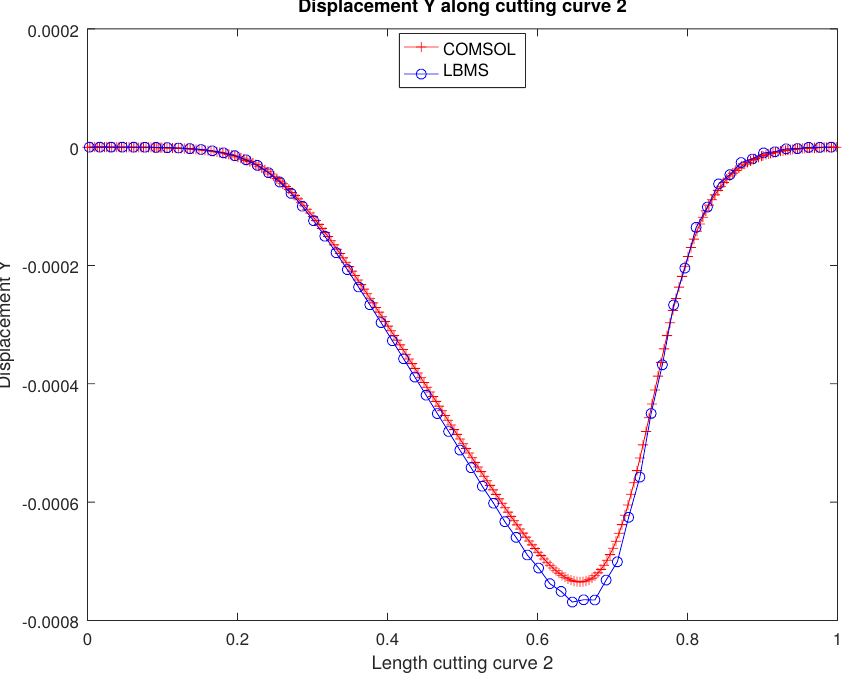
Figure A22. Second displacement components along cutting curve C 2 for case E = 200 GPa, ν = 0.15 with triangular